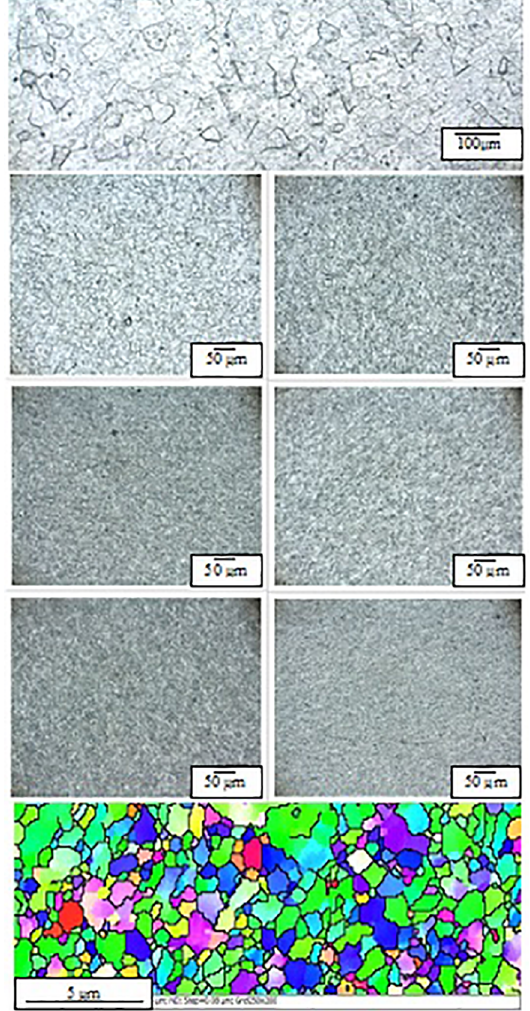
Figure 7. Ultimate Tensile Strength of Specimens